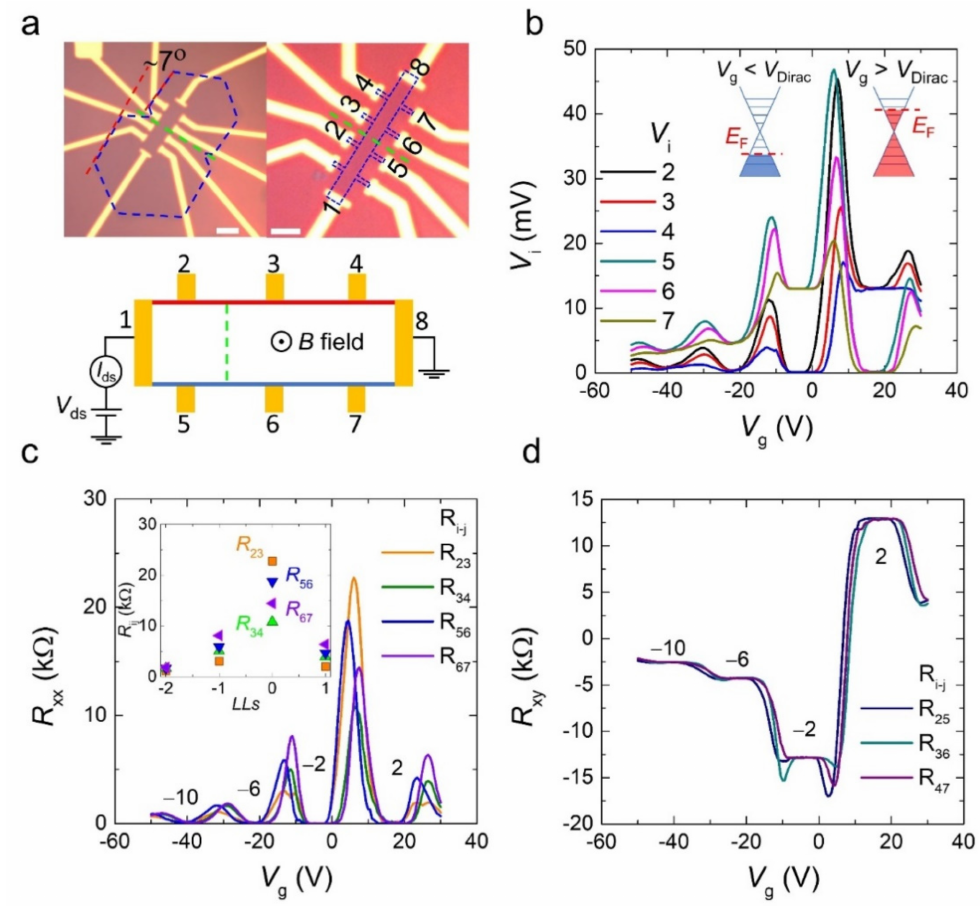
Figure 2. The quantum Hall (QH) state of graphene device (D2) with grain boundary (GB) at 2 K and 14 T with an applied current of I ds = 1 µ A. ( a ) Optical microscopy image of the device (top) and edge state potential of the device. The graphene is denoted by the blue dashed line. The green dashed lines indicate the GB position. The stitched angle is approximately 7 ◦ and indicated by red dashed lines. The scale bar is 3 µ m. ( b ) Gate voltage dependence ( V g ) of potentials measured at each voltage probe. ( c , d ) V g dependence of R xx and R xy ,